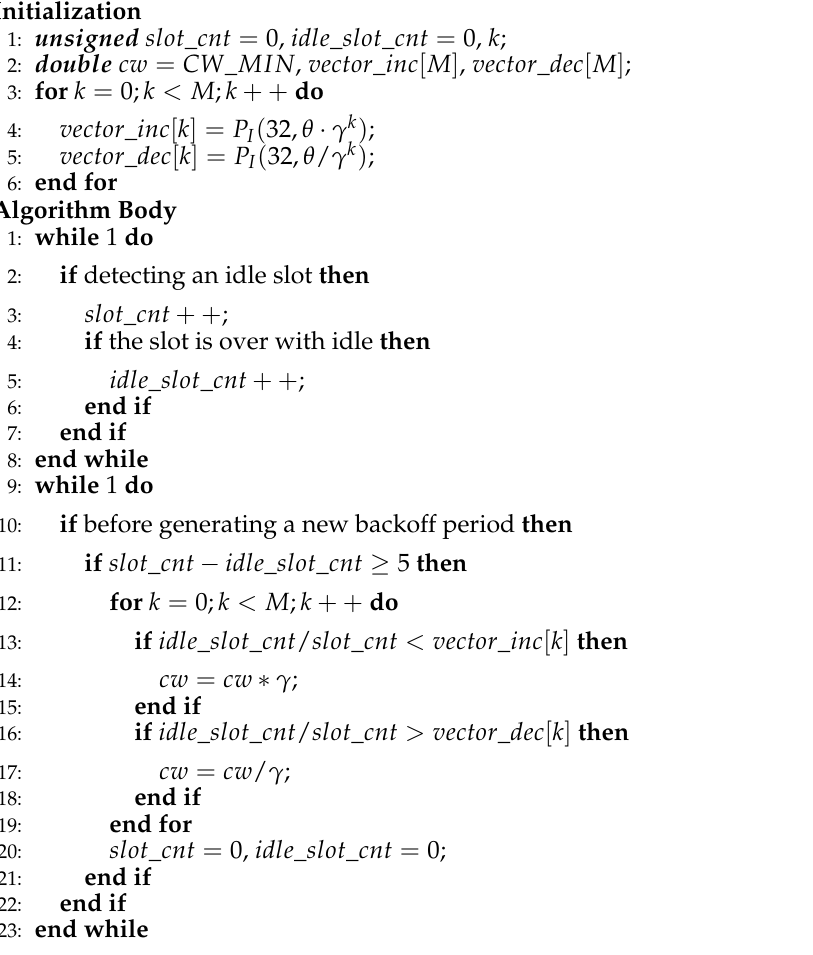
Algorithm 1 A M -Level contention window tuning algorithm with a minimum tuning rate of γ .